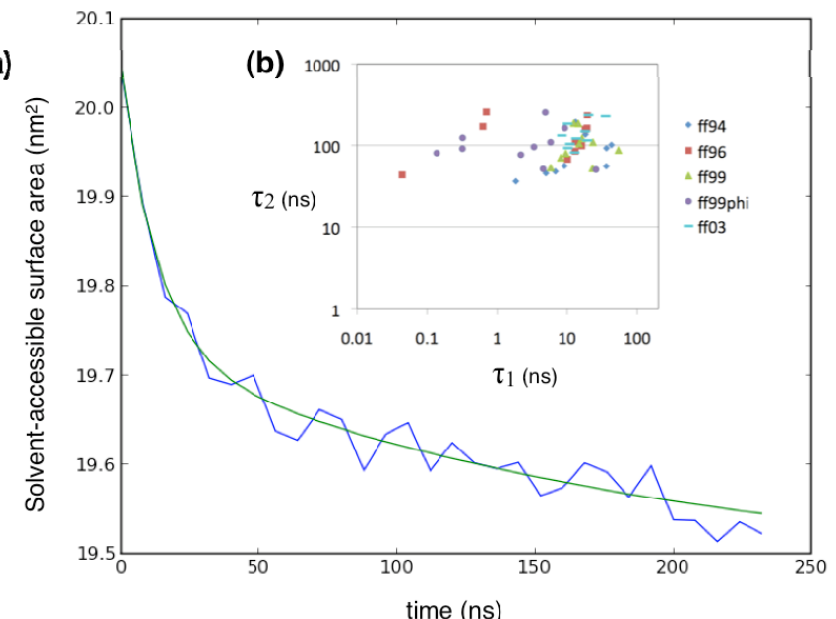
Figure 6. Simulated relaxation kinetics for D P D P-II, as characterized by average C=O solvent-accessible surface area. Description is as Figure